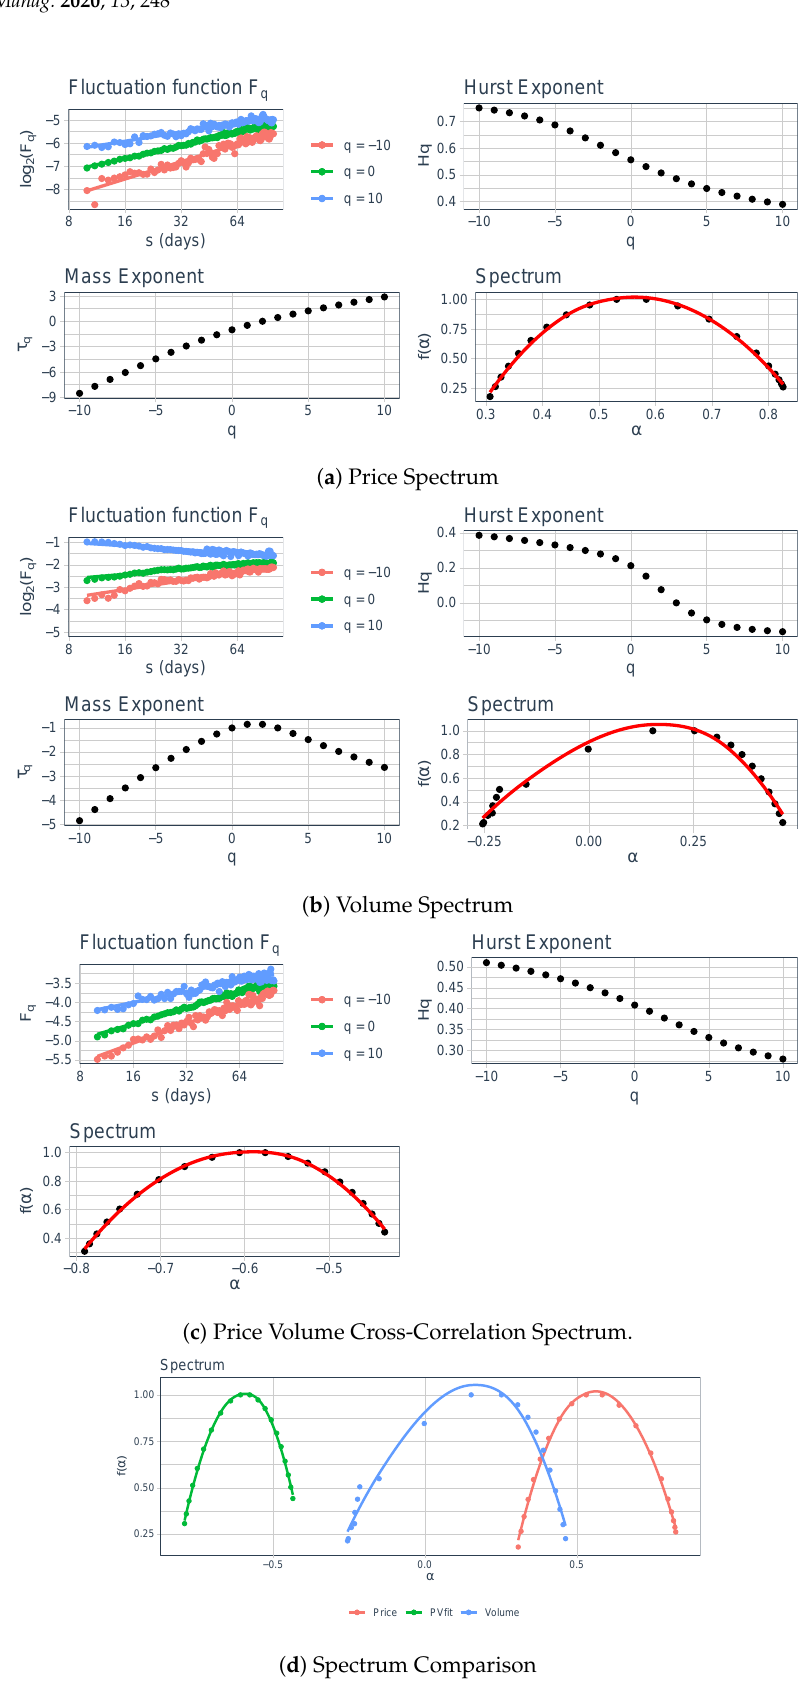
( d ) Spectrum Comparison Figure 8. Segment 4 price, volume, and price-volume cross-correlation